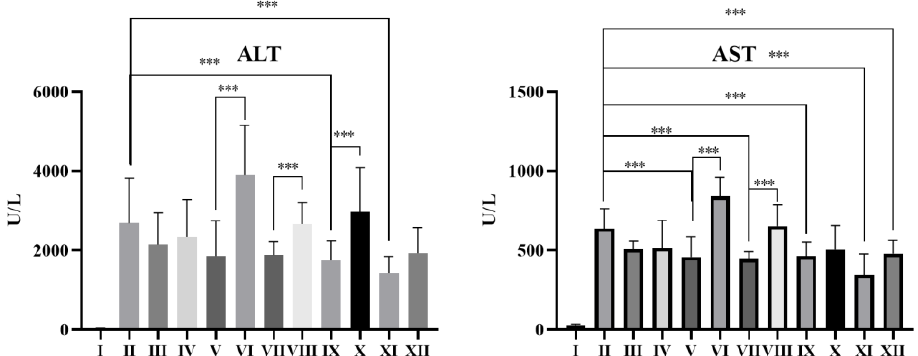
Figure 6. Effects of BAI and DG on serum ALT and AST levels in CCl 4 -treated mice. Compared with the normal control (group I), the levels of ALT and AST in groups II–XII were significantly increased ( p < 0.01); *** p < 0.05 compared with group Ⅰ .